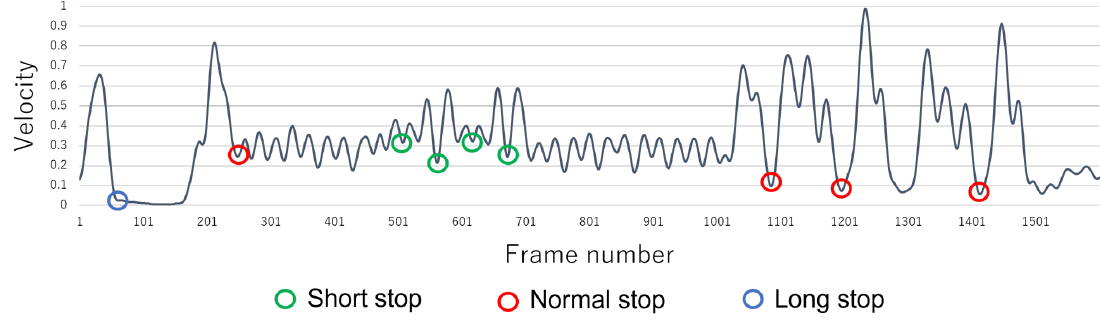
Figure 4. Example of velocity